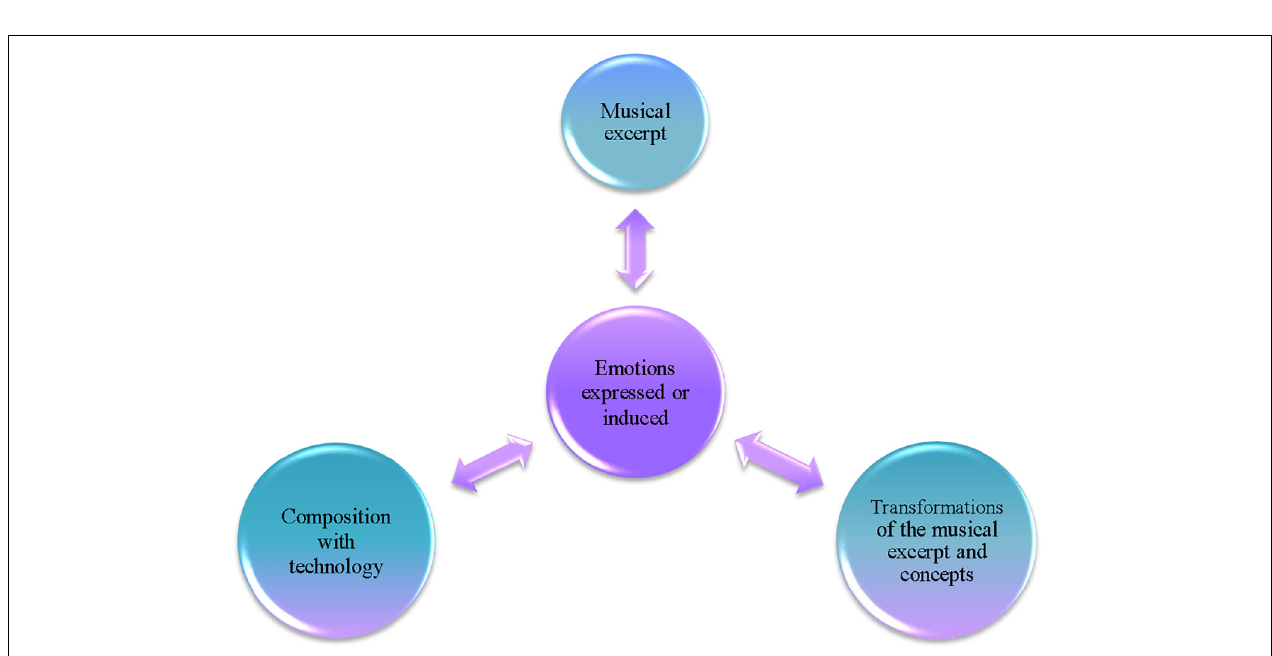
FIGURE 3 | A methodology for designing technology-enhanced learning in listening and composition: Teaching musical concepts and relating them with emotions through the use of technology (adopted from Macrides and Angeli, 2018a,b).